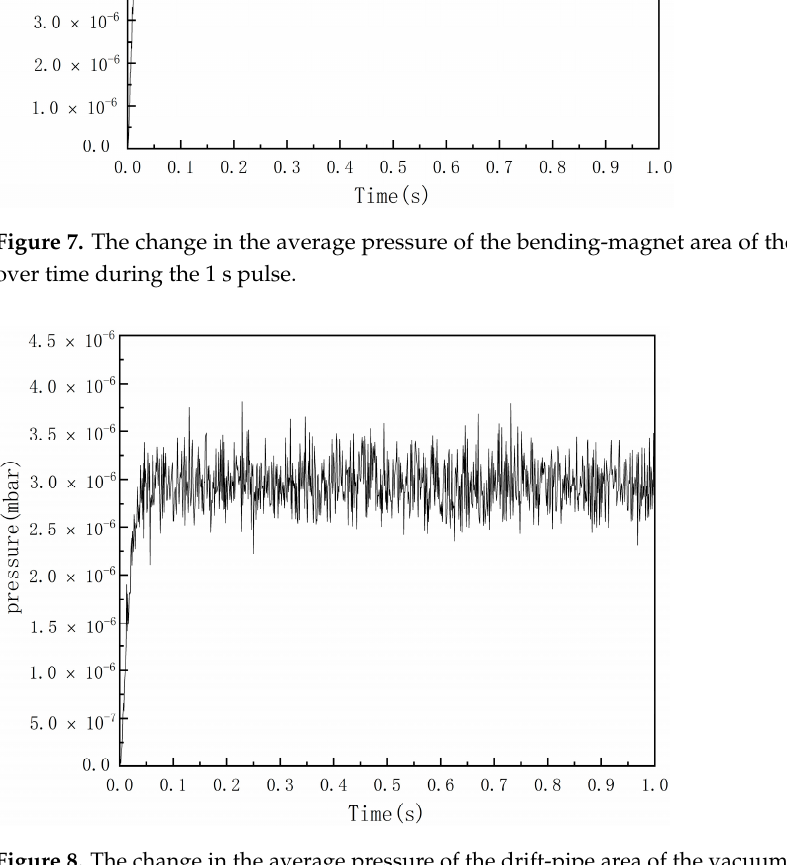
Figure 8. The change in the average pressure of the drift-pipe area of the vacuum chamber over time during the 1 s pulse.